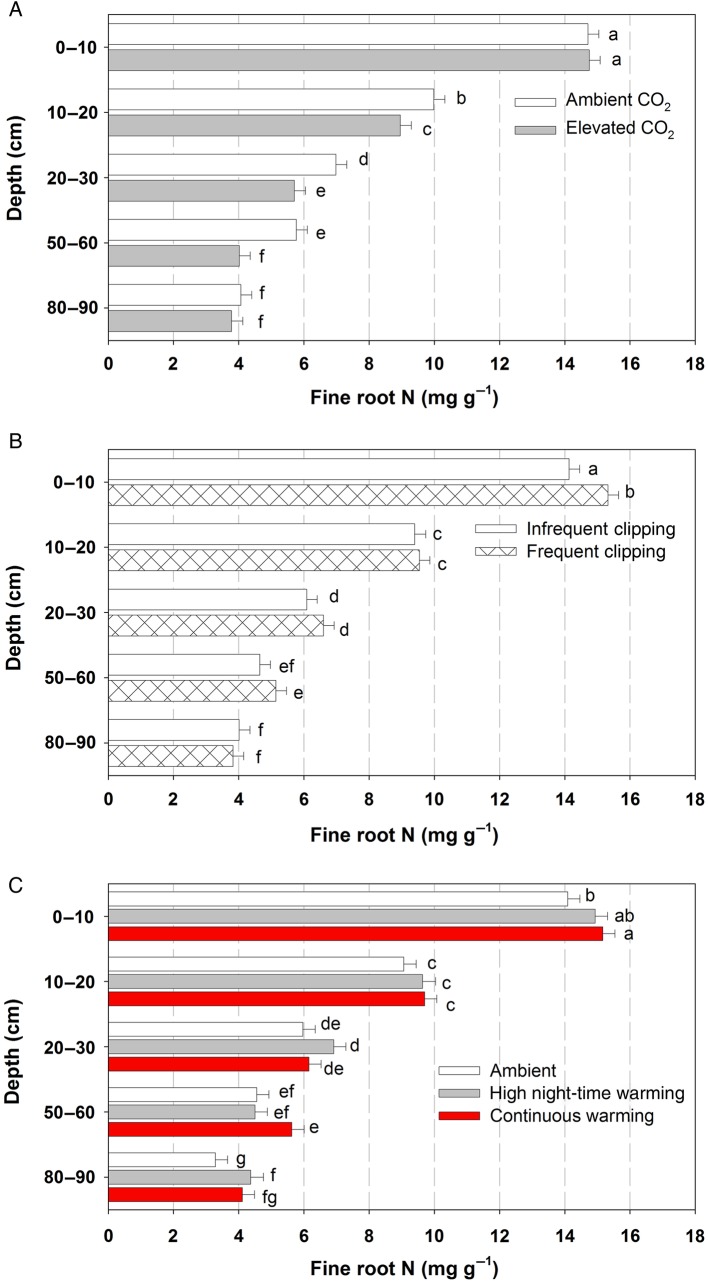
Effect of (A) atmospheric CO2 concentration, (B) clipping frequency and (C) warming treatment on fine root N concentration at five depths at the end of the experiment (March 2003). Treatments started in September 2001. Data are the least square means + SEM across treatments. Different letters indicate statistically significant differences at P < 0.05 using Student's t LSD test.